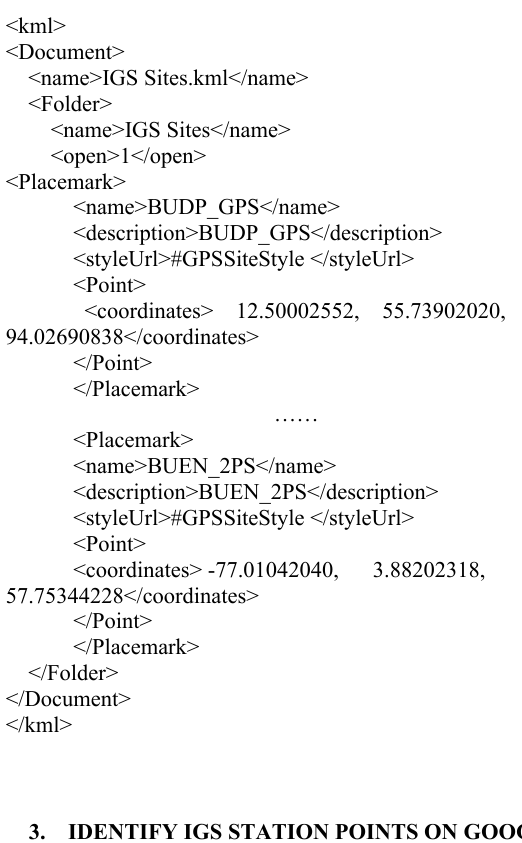
Table 1. Deviation in distance statistics